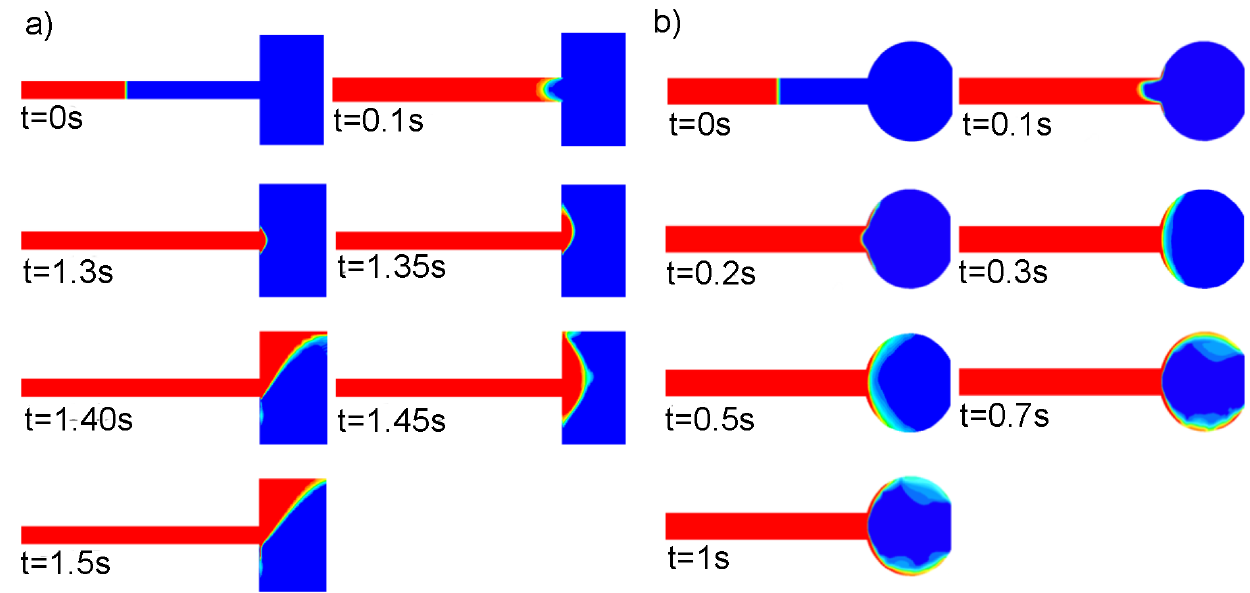
Figure 4. Sequences of the fluid motion in a, a) hydrophilic and b) super hydrophilic capillary.